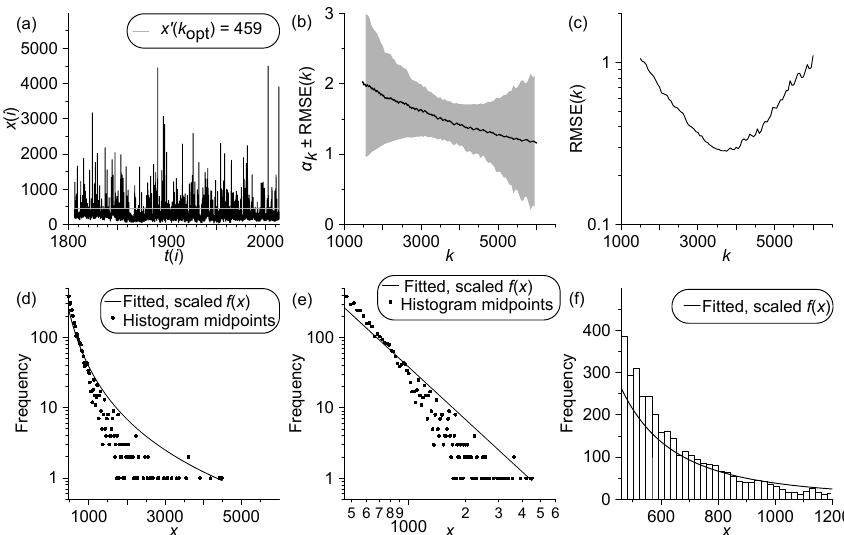
Figure 3. Application of heavy tail estimation with optimal order selection to observed data: (a) time series (dark line) and average daily runoff of the River Elbe at Dresden (Germany) during summer (May to October) from 1 May 1806 to 31 October 2013 ( n = 38272); units: m 3 s − 1 ; (b) sequence b α k (solid dark line) ± RMSE (k) (shaded) for the Hill estimator (right tail); (c) measure RMSE (k) ; (d) – (f) frequency plots showing densities and histograms at various axis scalings (cf. Fig. 2). The optimal order is k opt = 3732; it has been detected using a quasi-brute force search (see text). Data courtesy Wasser- und Schifffahrtsverwaltung des Bundes, provided by the Bundesanstalt für Gewässerkunde (BfG), Koblenz,